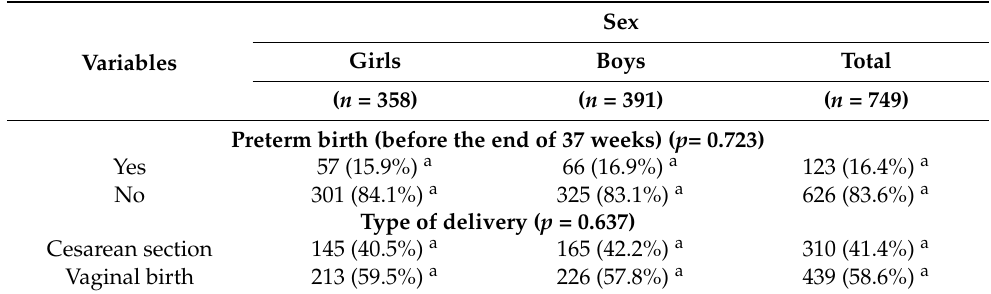
Table 1. Preterm birth and the type of delivery depending on the sex of the subjects. Variables